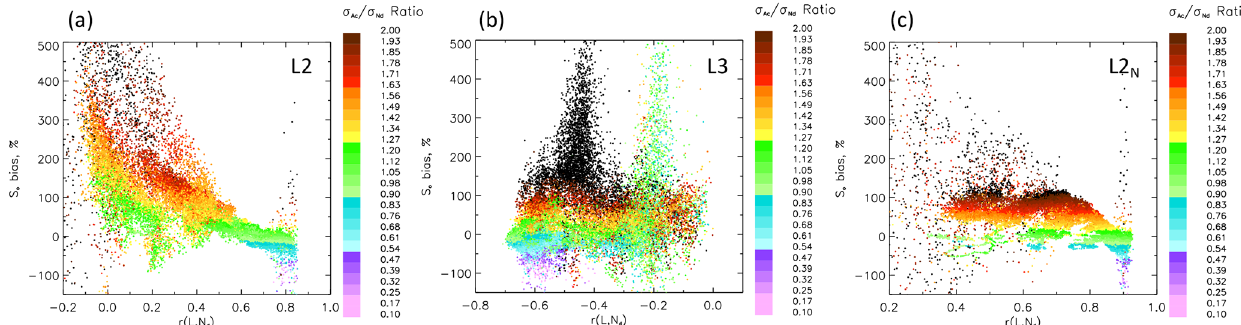
/σ N /σ N at 6km to σ A at 800m (the σ ratio). Note the clear dependence c c d d